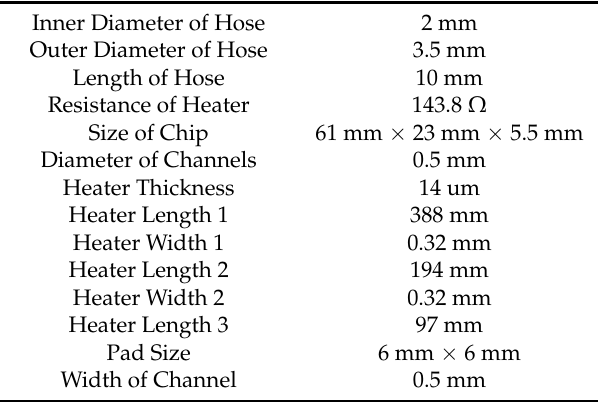
Figure 2. ( a ) Frontside; ( b ) backside; ( c ) sliced view; ( d ) side and sliced view of the preconcentrator filled with an adsorption material. Table 1. Dimensions of the ceramic